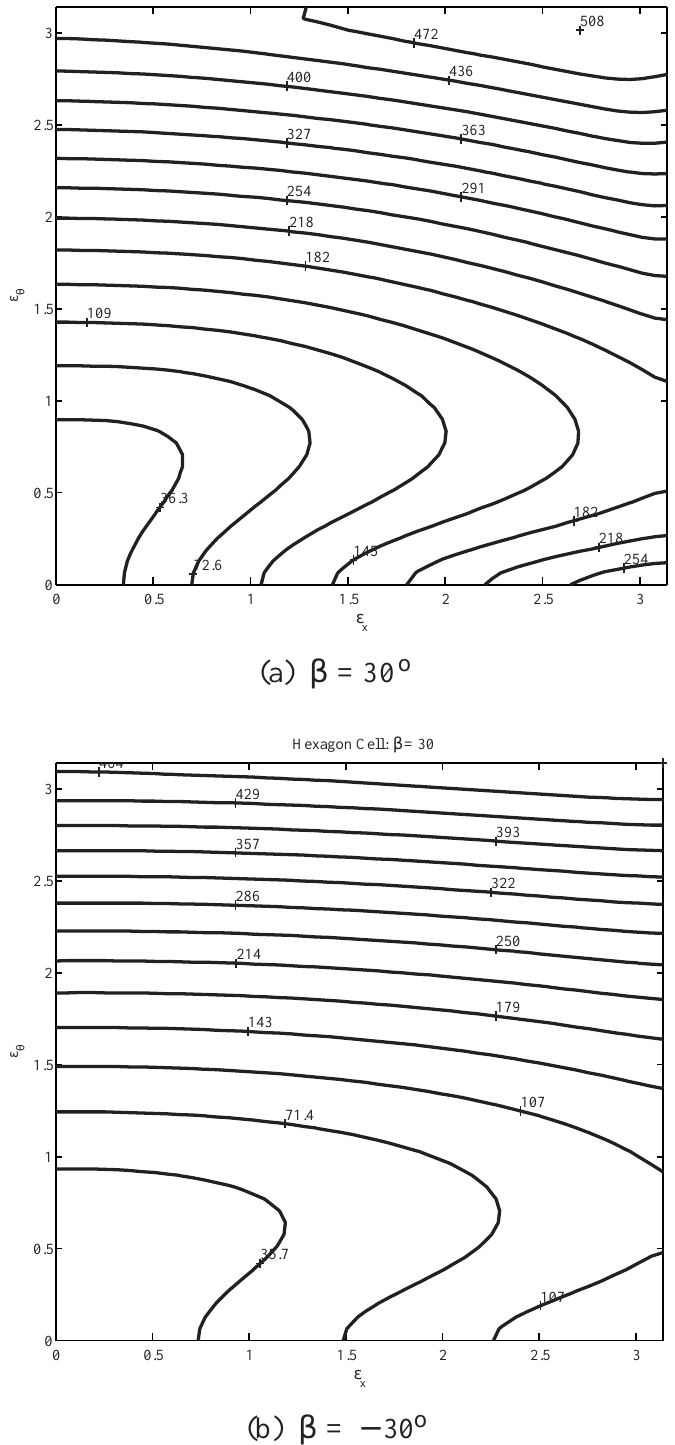
Fig. 11. Phase constant surfaces for hexagonal